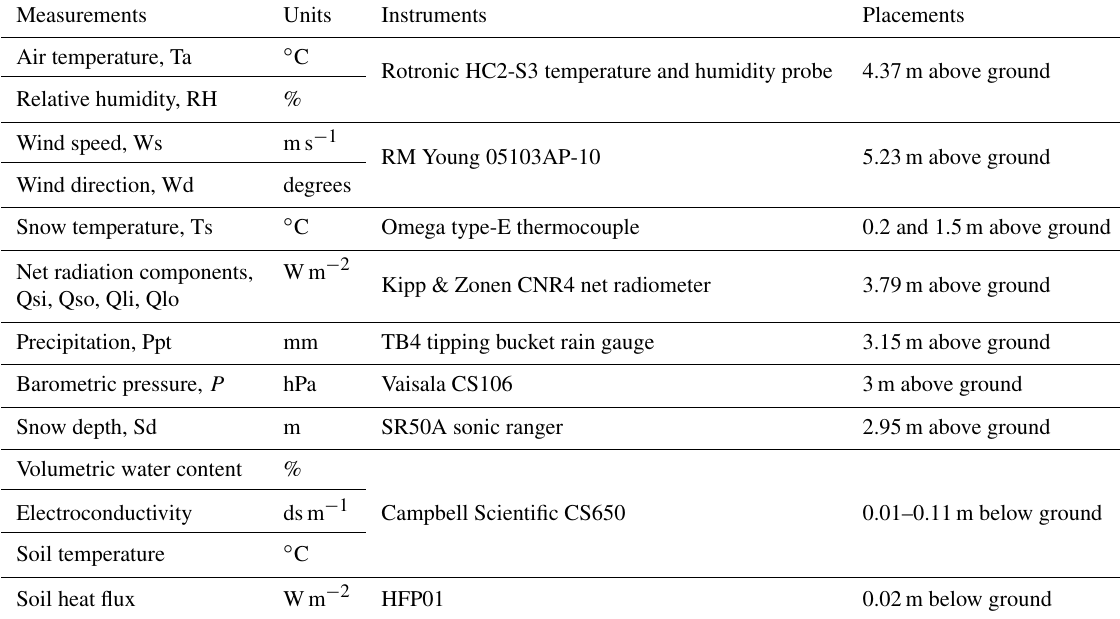
Table 3. Meteorological measurements and instruments installed at Peyto